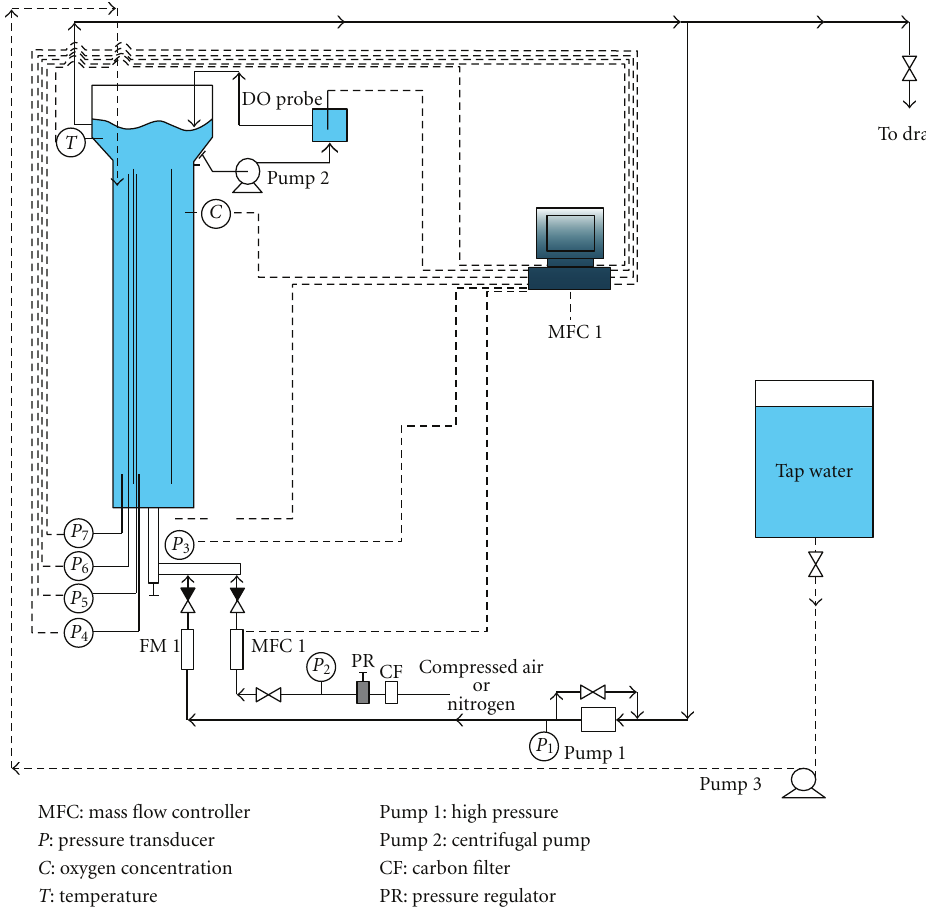
Figure 1: Schematic representation of the experimental